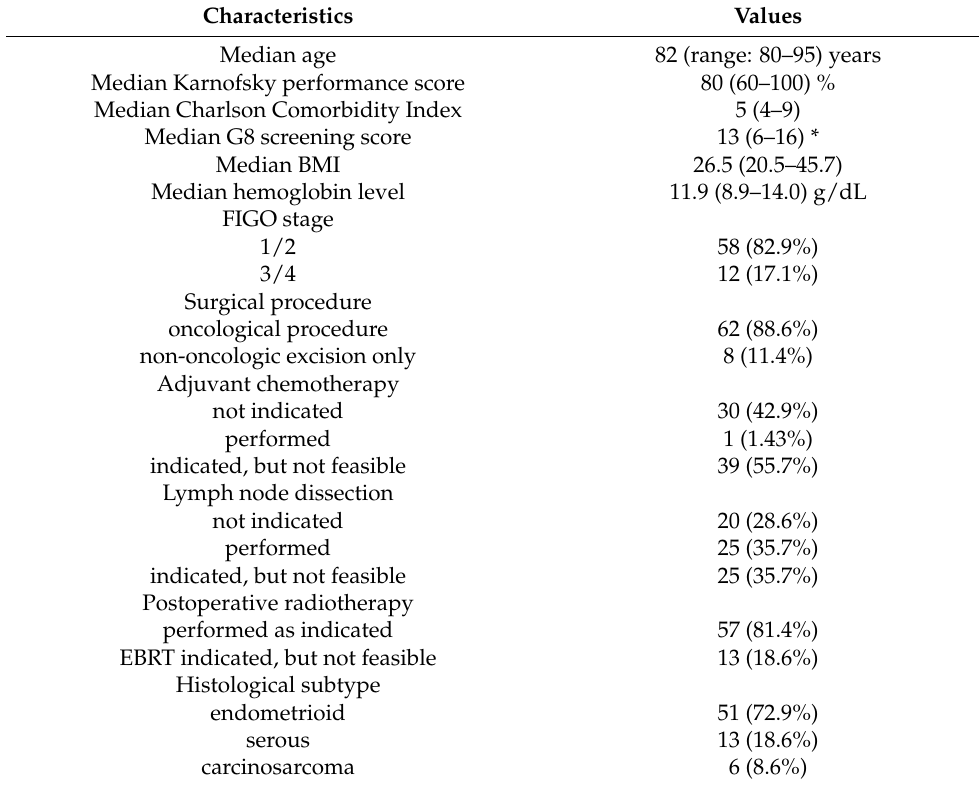
Table 1. Patient characteristics.